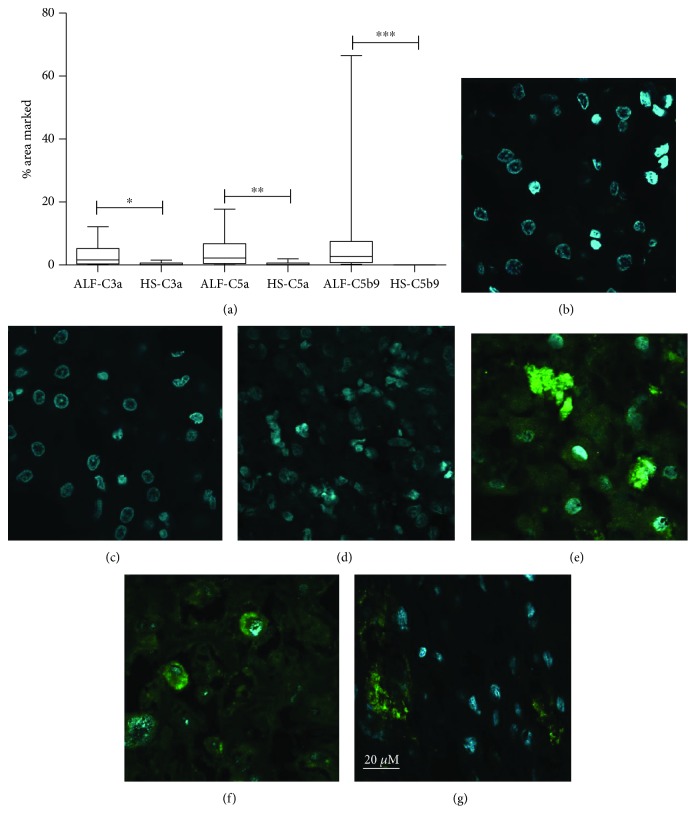
Liver deposit of anaphylatoxins C3a, C5a, and C5b/9 (MAC): (a) percentage of the area marked with anaphylatoxins in healthy subjects (HS) and acute liver failure (ALF) samples of liver tissue; (b–g) immunofluorescence assay (IFA) of liver samples tested for αC3a (b, e), αC5a (c, f), and αC5b/9 (d, g); the yellow underlined figures are from healthy subjects (b, c, d); the red underlined figures are from acute liver failure patients (e, f, g). Confocal microscopy zoom was of 400-fold.